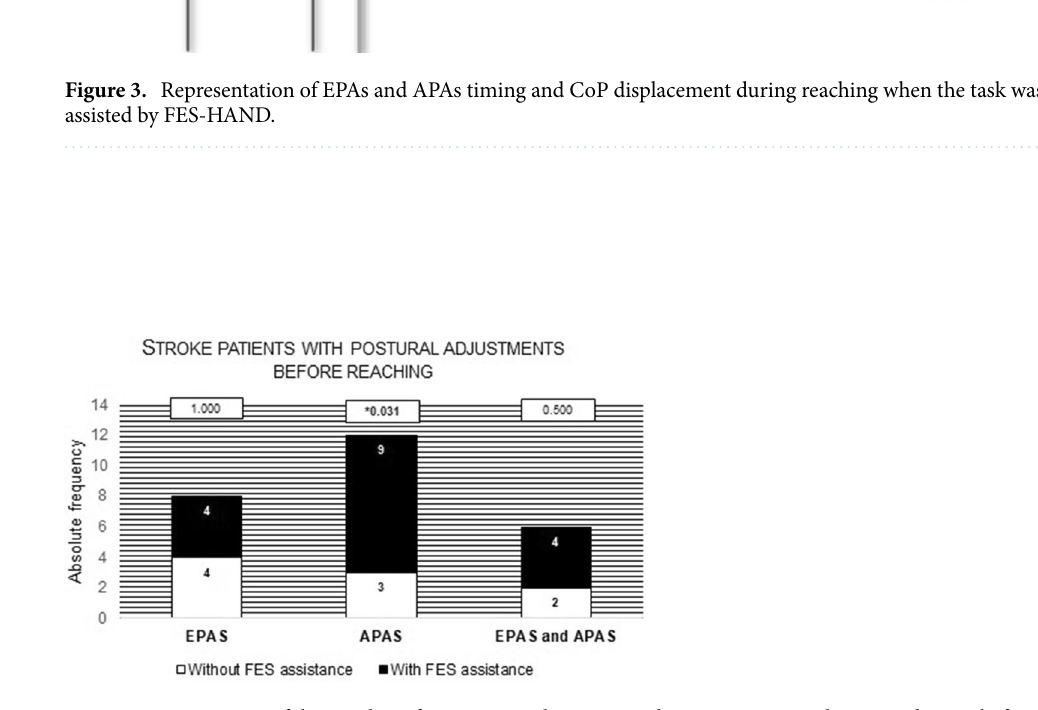
Figure 4. Description of the number of participants that presented EPAs or APAs and EPAs and APAs before the beginning of the turning on the light with and without FES-HAND assistance. Proof values (p values) from between conditions comparisons are presented. Statistically significant values were identified in bold and with